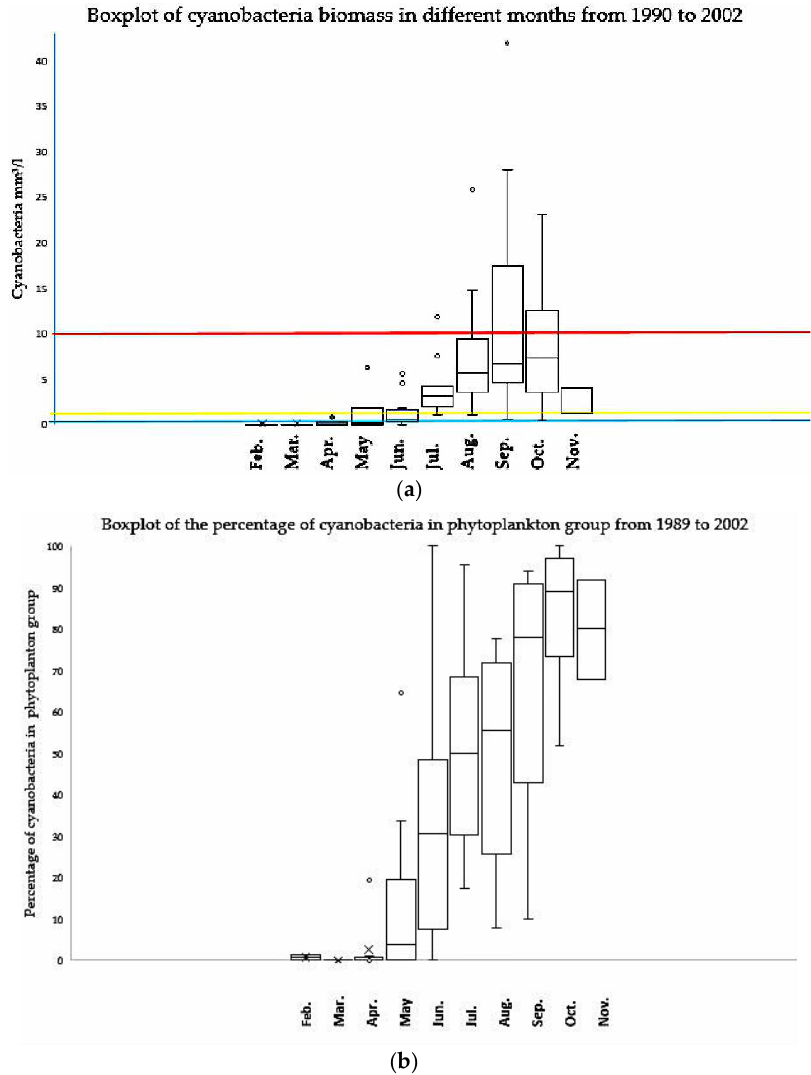
Figure 1. ( a ) Seasonal patterns of cyanobacteria biomass (mm 3 /L) in Lake Vombsjön during 1990 to 2002 (the blue line: 0.2 mm 3 /L is WHO (World Health Organization alert level 1 for drinking water waters; yellow line 1 mm 3 /L is Finnish drinking water for actions taken such as risk assessment and inform authorities; Red line is 10 mm 3 /L is WHO alert level 2 for drinking waters); ( b ) Seasonal patterns of cyanobacteria relative abundance found in Lake Vombsjön 1989–2002.